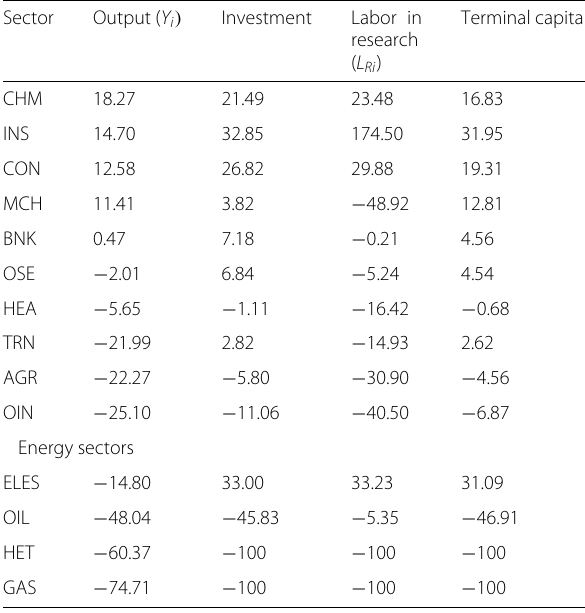
Table 4 Changes in 2050 output, investment, high-skilled labor and terminal capital by sector in 1.5 tCO 2 p.c. scenario (in percentage relative to